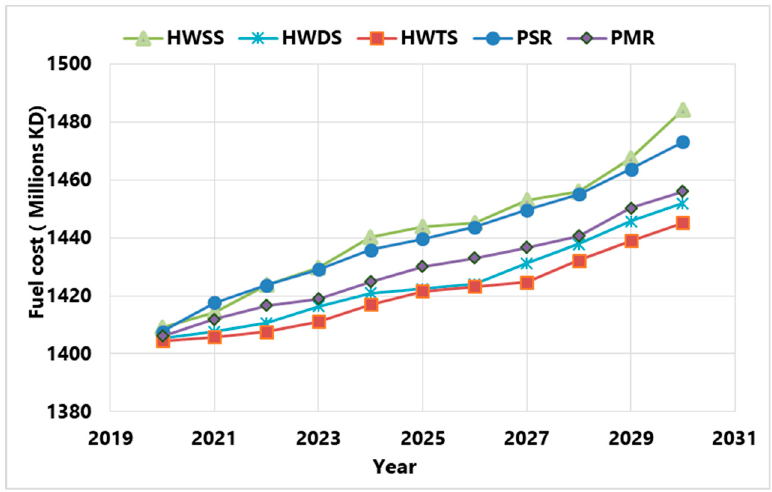
Figure 8. Forecasted fuel budget in millions of Kuwaiti Dinars for the upcoming ten years based on the power generation prediction of all proposed models.